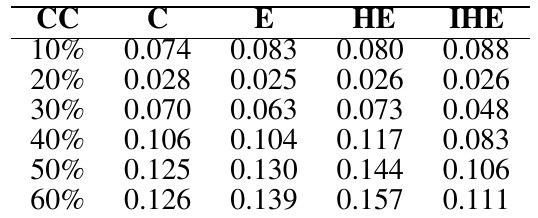
shape and 60% CC.